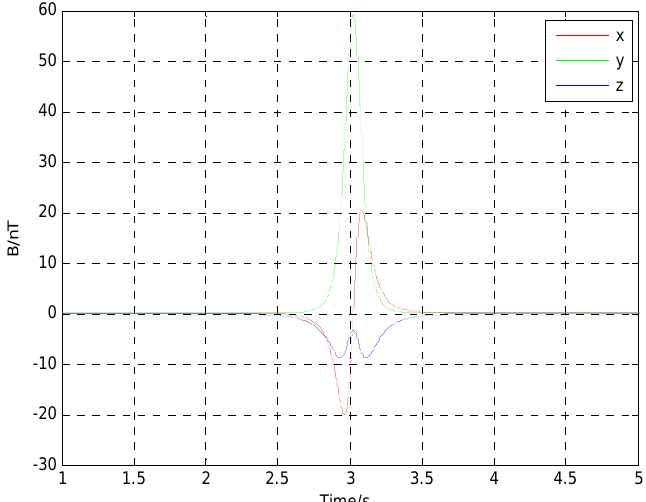
Figure 5. Amplitude curve of the alternating magnetic field data obtained by coherent demodulation.